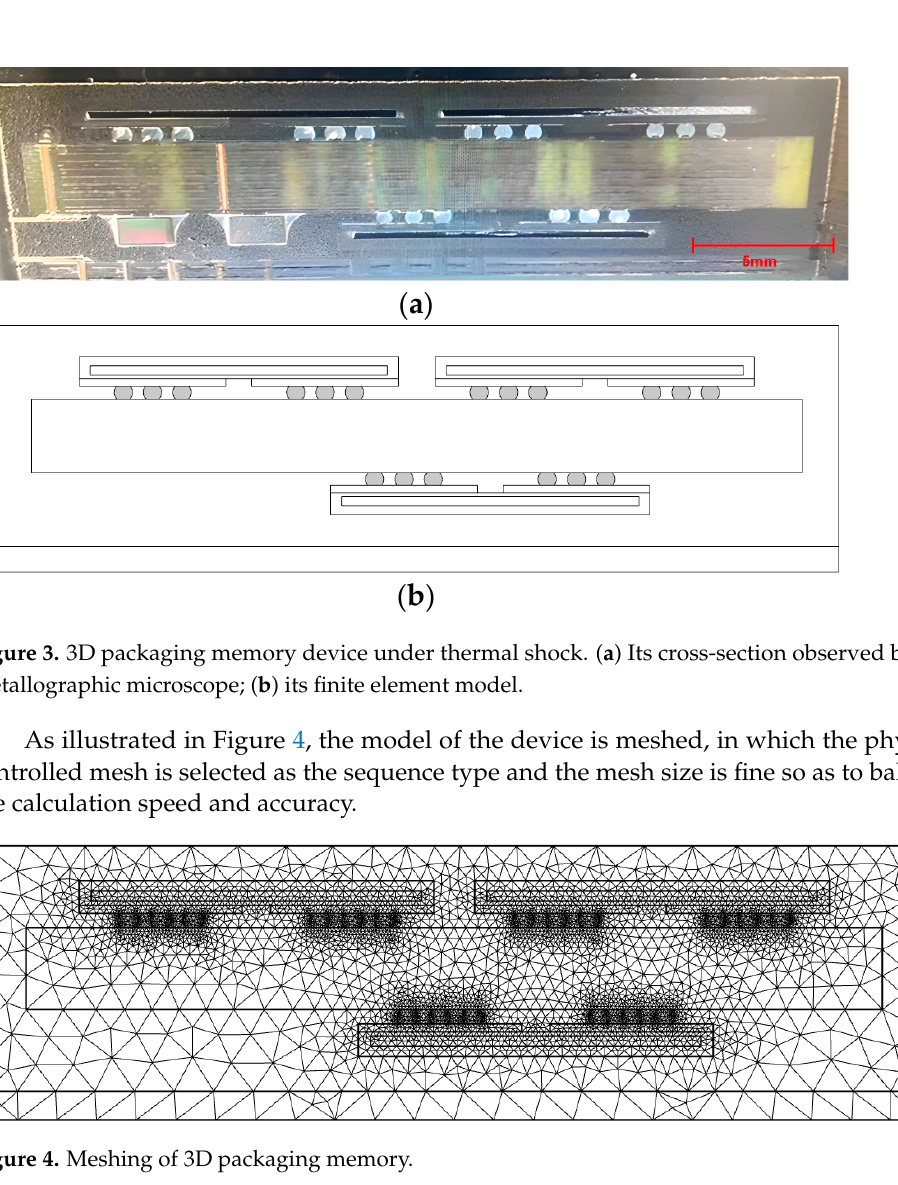
Figure 4. Meshing of 3D packaging memory.